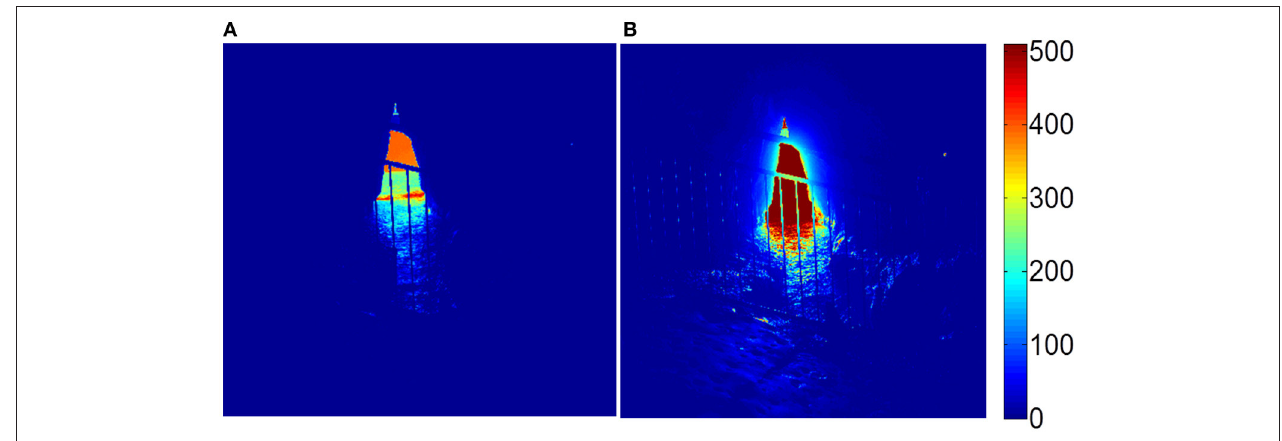
FIGURE 2 | Images of the I- component of the Stokes vector from the cave opening using (A) short exposure, and (B) long exposure. The units are